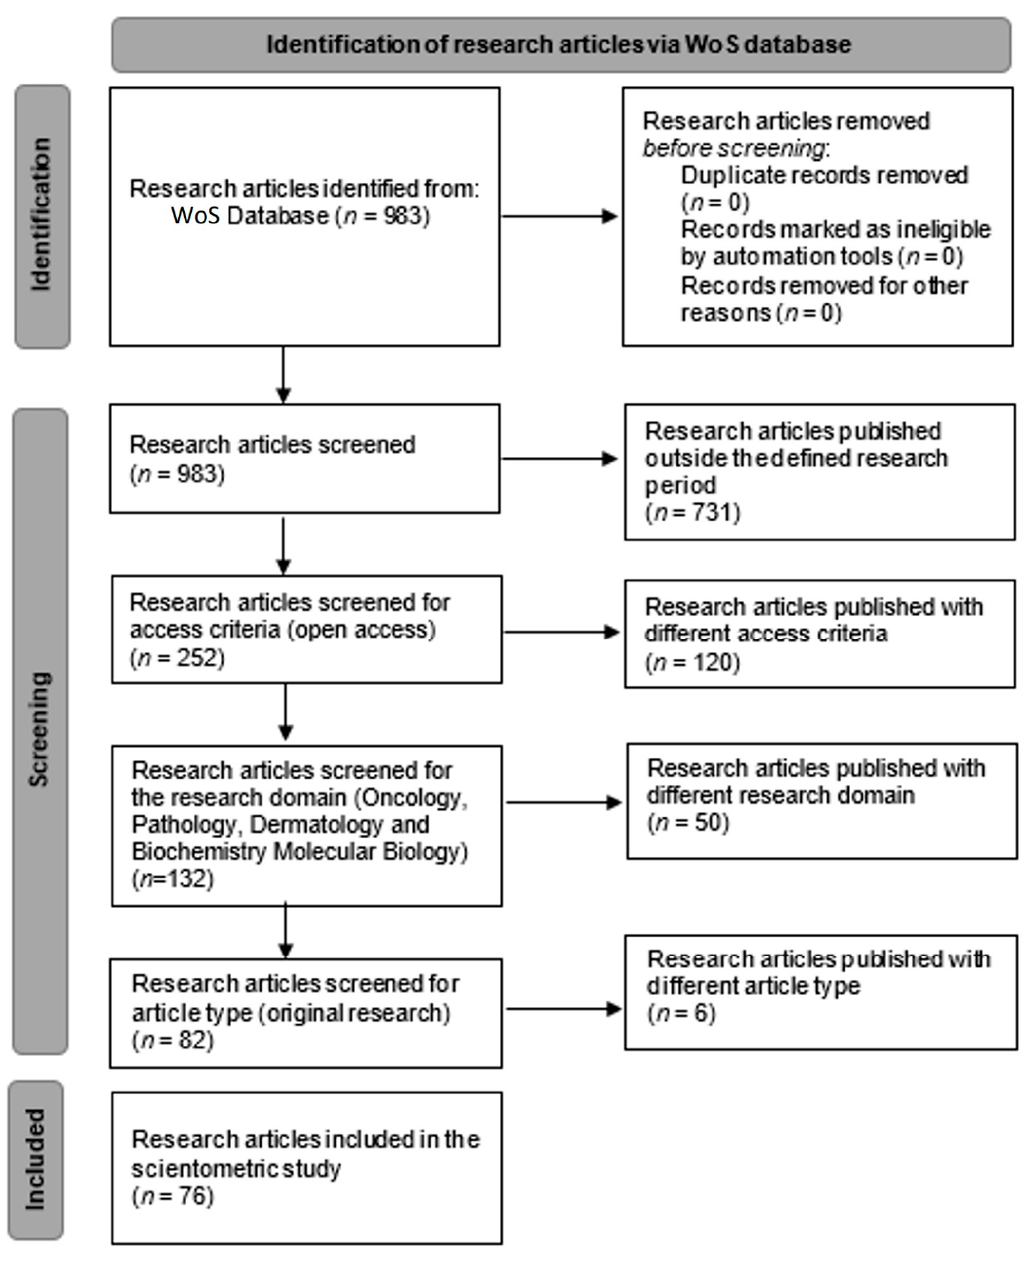
Figure 1. PRISMA chart of workflow—identification of research articles via WoS database.